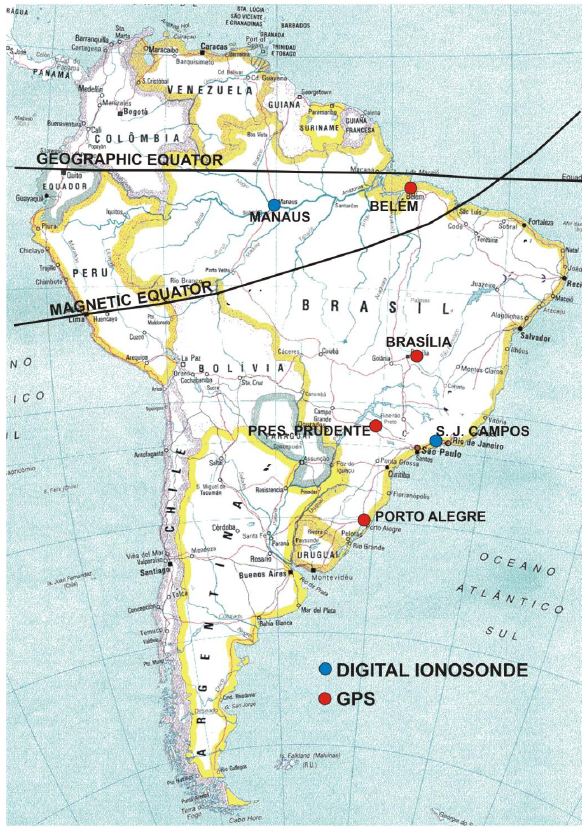
Figure 1 678 Fig. 1. A map of South America showing the locations of the digital ionosonde and GPS stations in Brazil, used in the present investiga- tions. Also, geographic and dip equators are